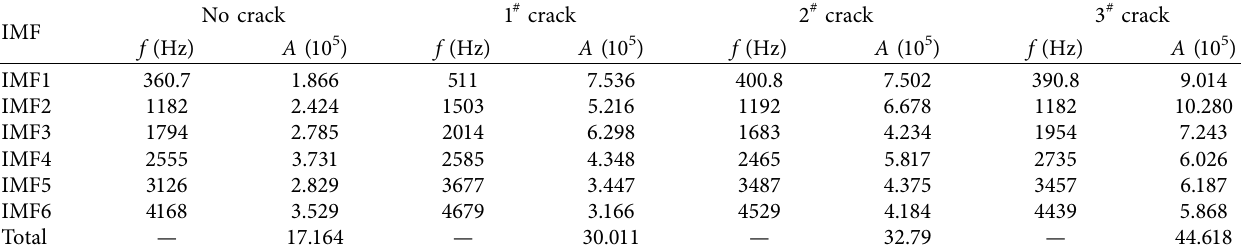
Table 5: Central frequency and amplitude of each IMF.